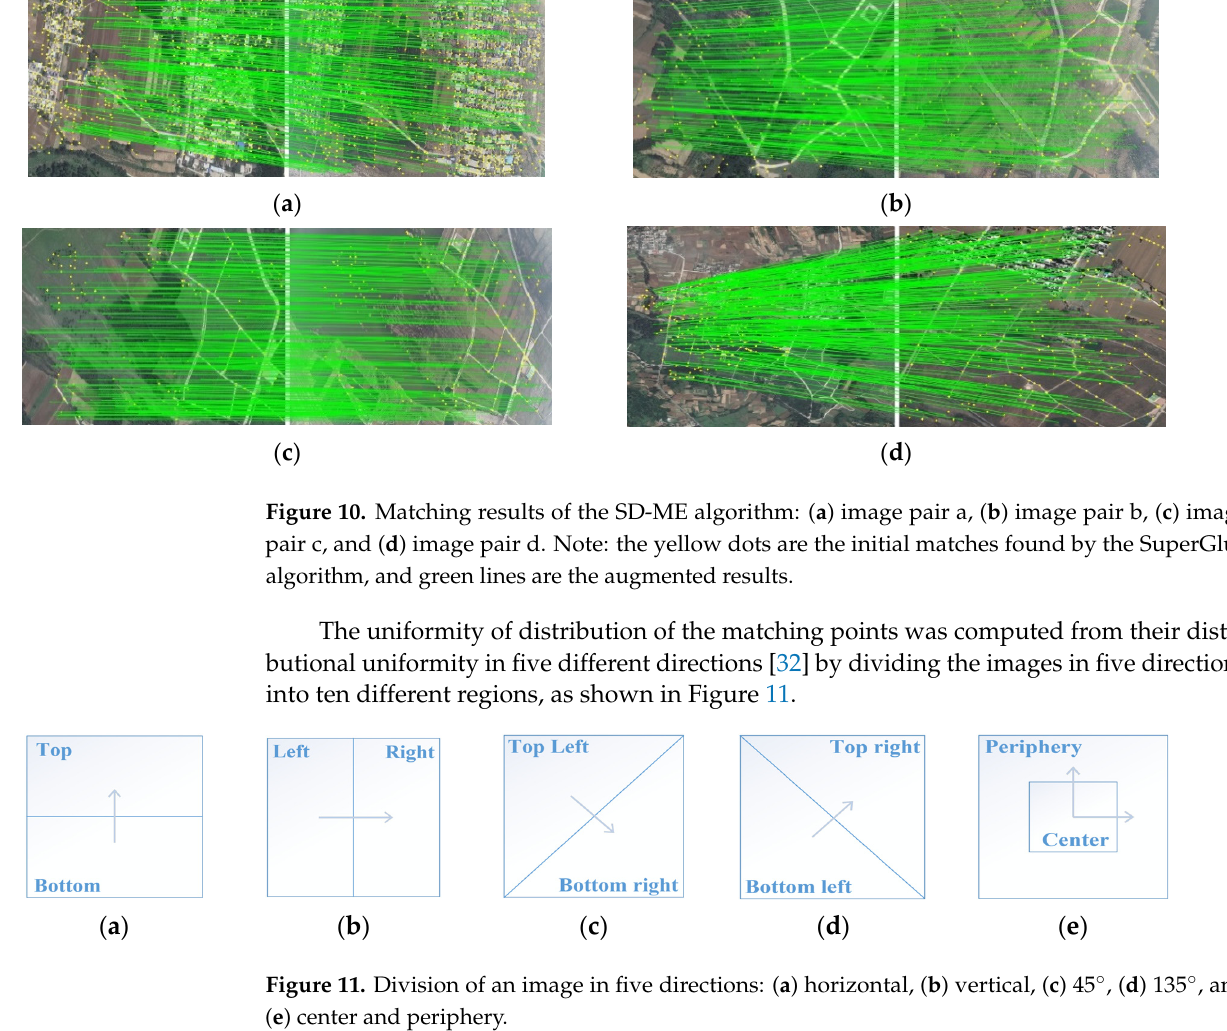
Figure 10. Matching results of the SD-ME algorithm: ( a ) image pair a, ( b ) image pair b, ( c ) image pair c, and ( d ) image pair d. Note: the yellow dots are the initial matches found by the SuperGlue algorithm, and green lines are the augmented results.